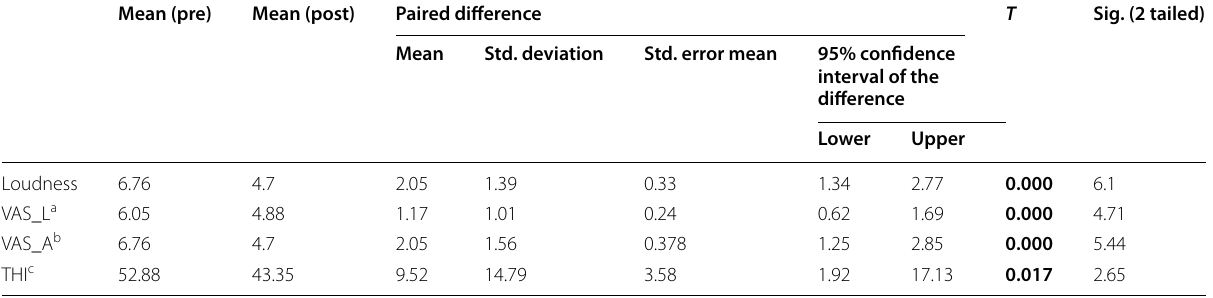
Table 2 The results of the subjective and psychoacoustic evaluations before and after tinnitus